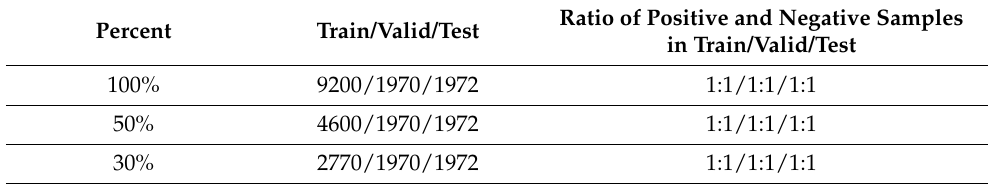
Table 2. BindingDB datasets of different proportions.